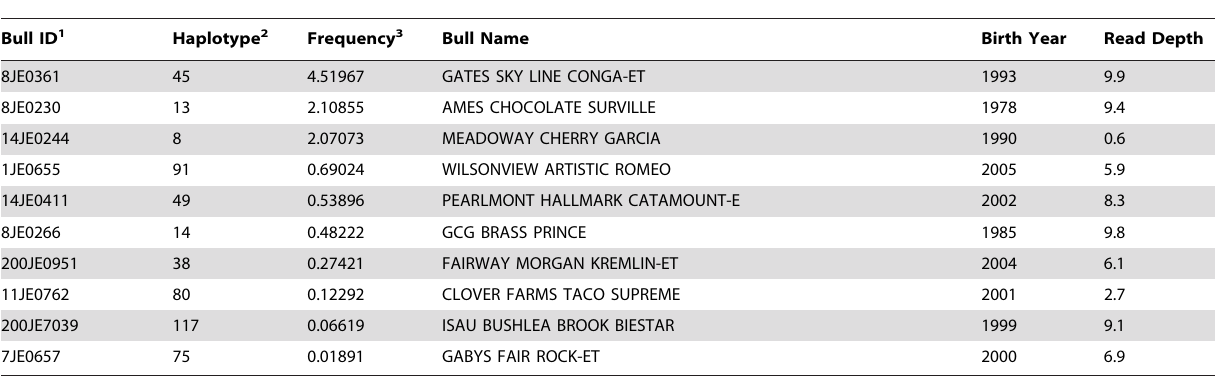
Table 2. The ten JH1 carrier bulls used for next generation sequencing.